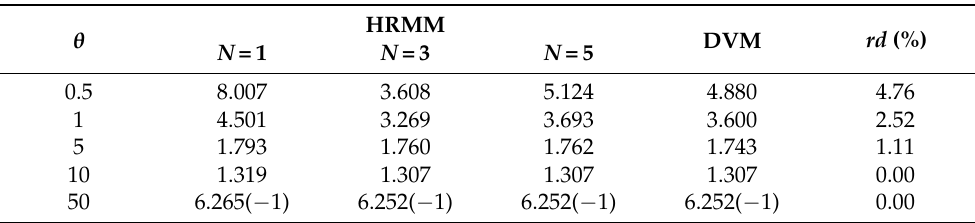
Table 3. Oscillatory Stokes flow; dimensionless penetration depth ( L ) for various values of θ based on the HRMM, with N = 1,3,5 and the